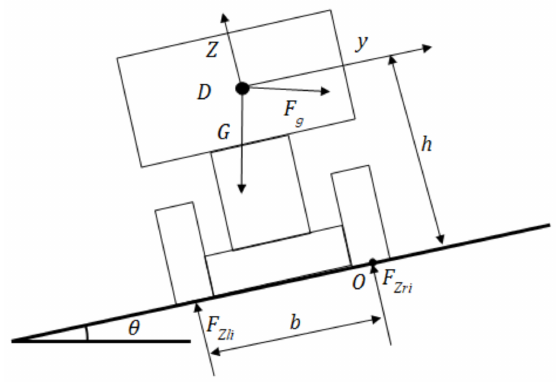
Figure 3. Vehicle rollover quasi-static